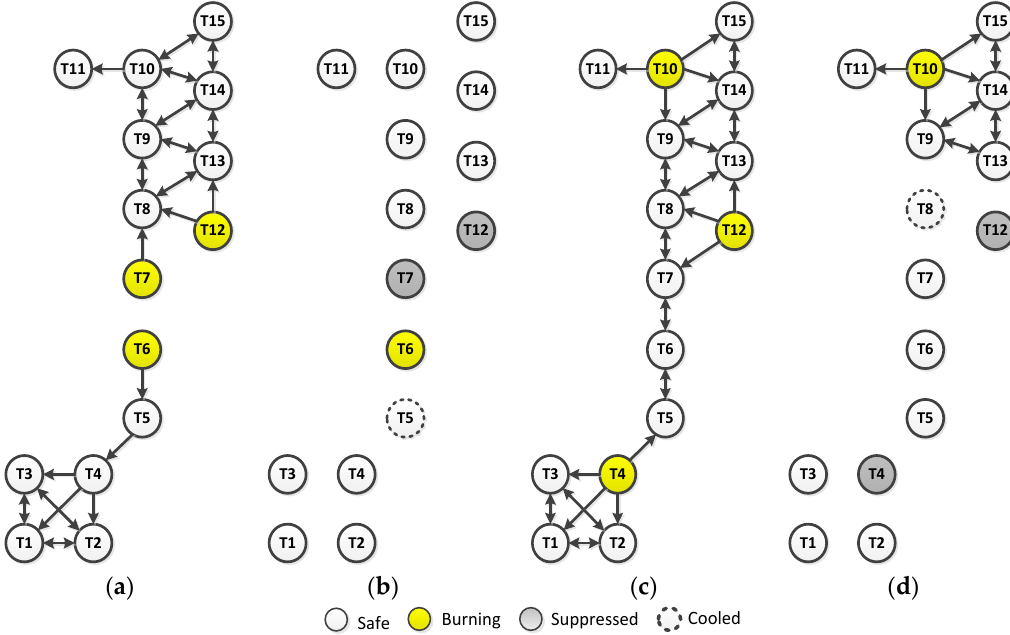
Figure 11. ( a ) Fire spread paths in the case of Scenario A. ( b ) Fire spread paths after the implementation of firefighting in the case of Scenario A. ( c ) Fire spread paths in the case of Scenario B. ( d ) Fire spread paths after the implementation of firefighting in the case of Scenario B.